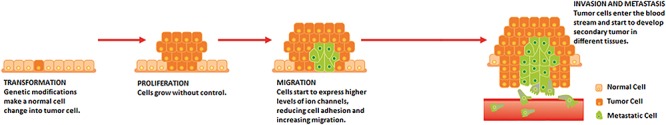
Tumorigenesis process. The interaction between DNA and different carcinogenic factors can cause mutations in genes that are responsible for controlling several important cellular functions, such as the regulation of apoptosis. The injured cell then has a lack of proliferation control, which leads to the formation of tumors. The tumor can present a higher degree of aggressiveness, in which tumor cells have characteristics like the loss of cell adhesion and increase in expression levels of ion channels. In some aggressive cancers, cells can reach the blood stream and start the development of a cancer in new sites throughout the body (metastasis). (Figure adapted with permission from Araújo P et al. Ciência Hoje 2014; 54: 36-39. (78)).